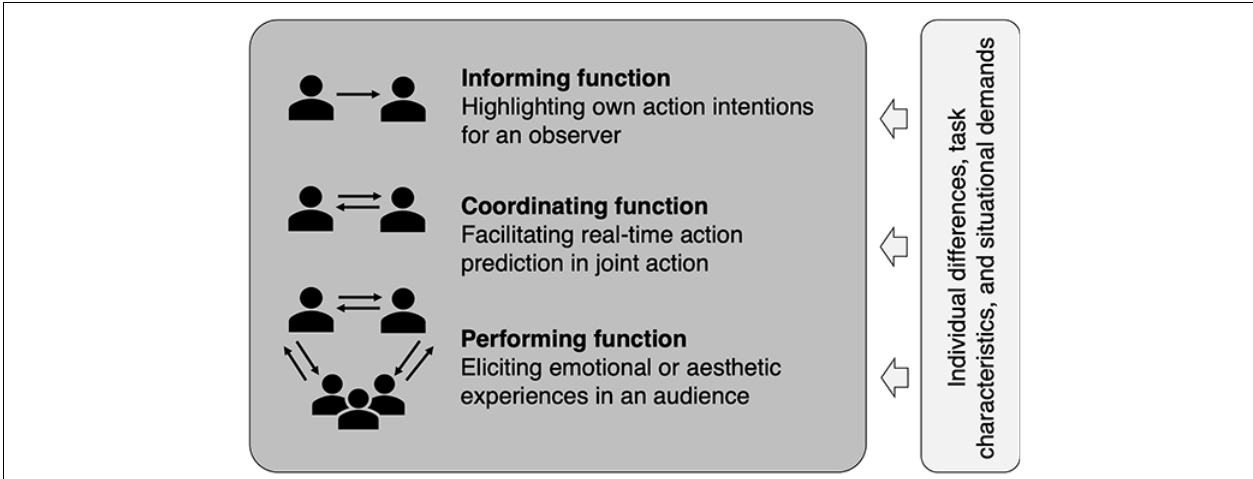
FIGURE 1 | An illustration of three central functions of sensorimotor communication, indicating the main directionality of information exchange between individuals and potential influencing factors on their communication. The number of involved individuals can vary in each context.